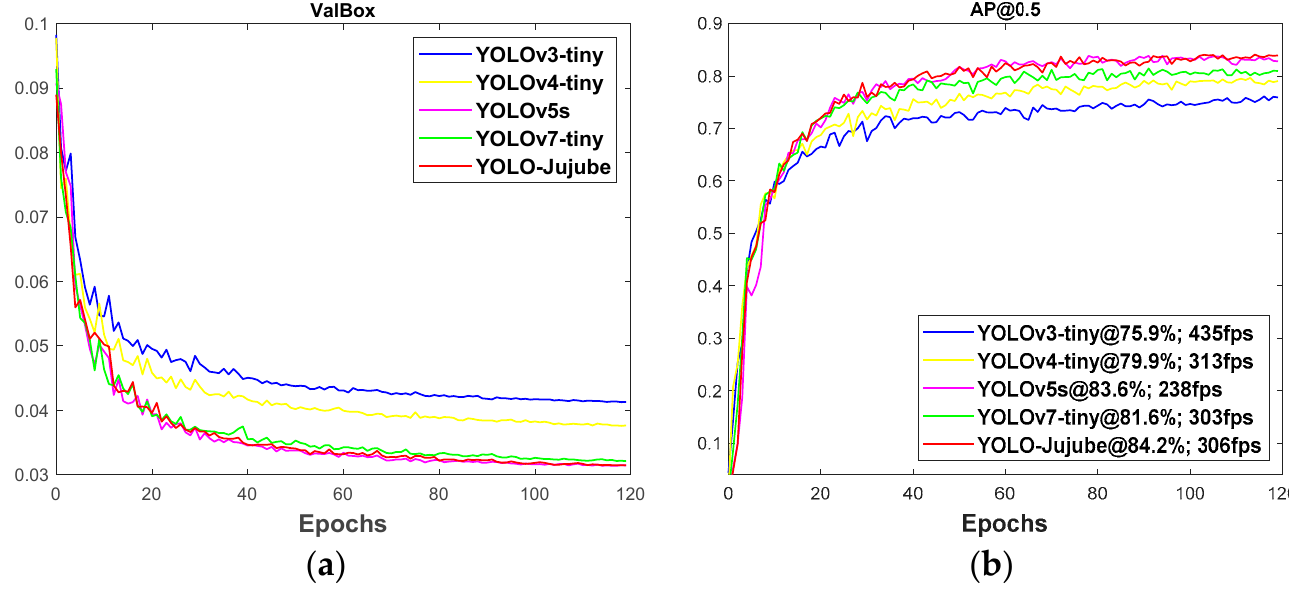
Figure 4. Trained methods’ results for ( a ) validation box; ( b ) AP@0.5. Table 4. Performance of the methods on the test